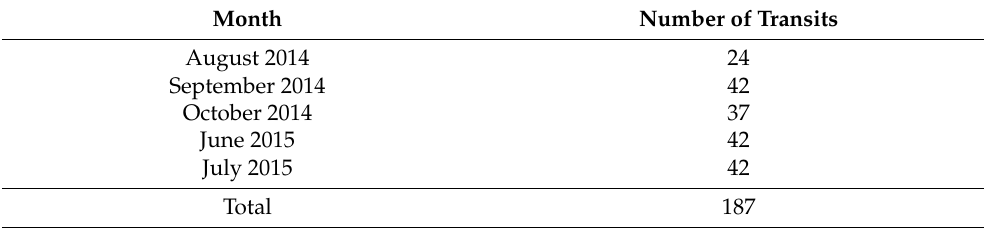
Table A8. Central Adriatic Separation Scheme—number of cruise ships’